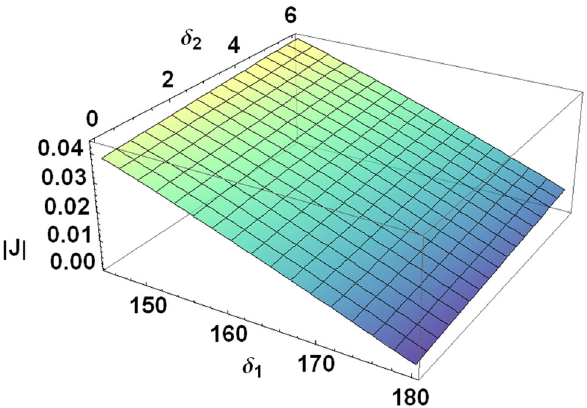
Fig. 10 Behavior of the absolute value of Jarlskog invariant J as the function of δ 1 in the range 145 ◦ –180 ◦ , and δ 2 in the range 0 ◦ –6 ◦ for δ = 1 ◦ in the exponential parameterization of the neutrino mixing 3 matrix. The ranges are based on 3 σ spread of Best